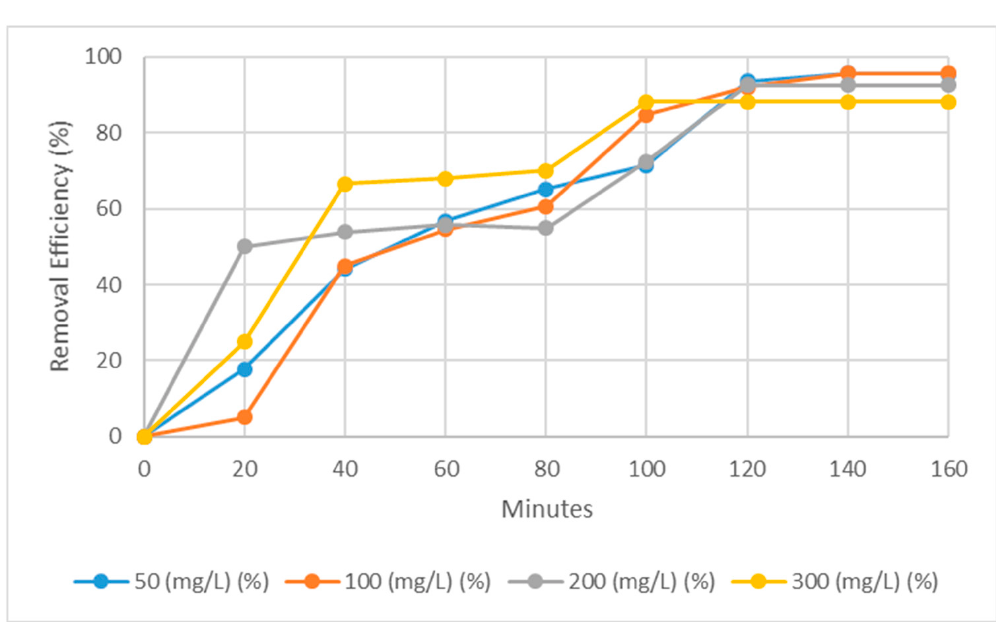
Figure 2. (EC) removal percentages.